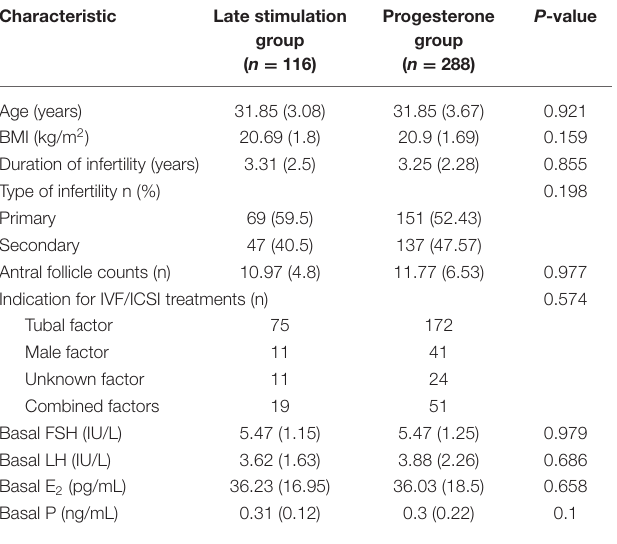
TABLE 1 | General information regarding patients undergoing IVF/ICSI